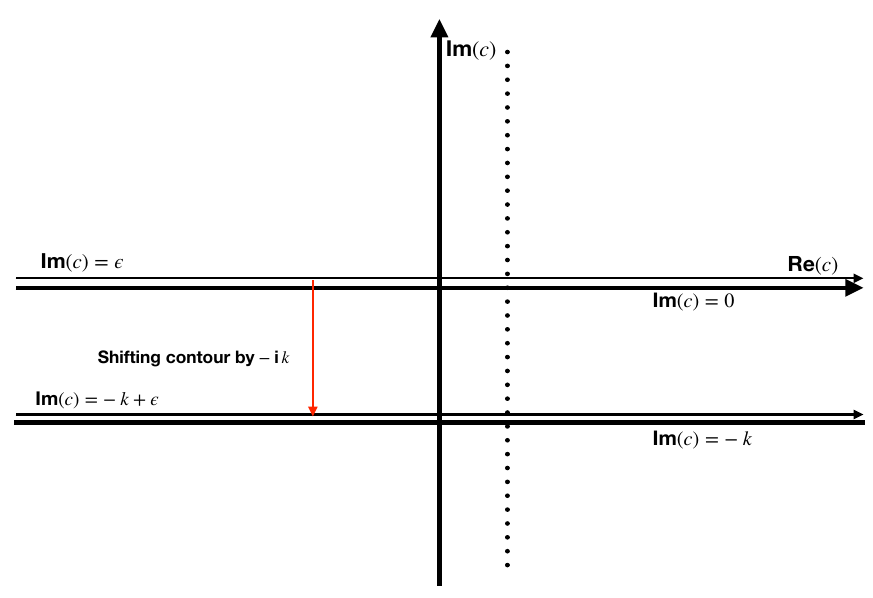
Figure 1 . For a fixed value of the Casimir λ 2 we show the discrete set of poles in the momentum c -plane. When λ 2 = 0 , there is a pole along the contour of integration. To avoid the singularity the contour in the c -plane is shifted by i (cid:15) . Upon shifting the c -contour by − i k , we see that a finite number of poles is picked